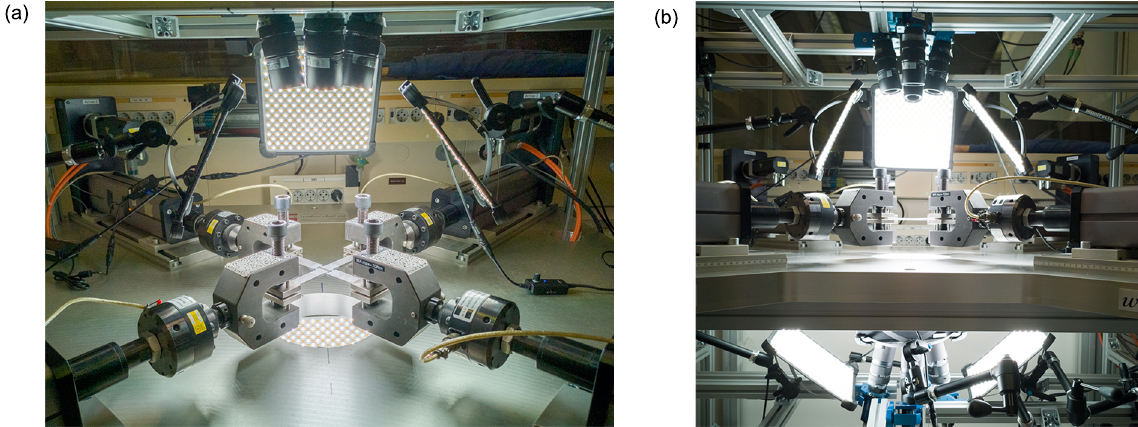
Figure 5. ( a ) Biaxial test machine, ( b ) lighting system and camera